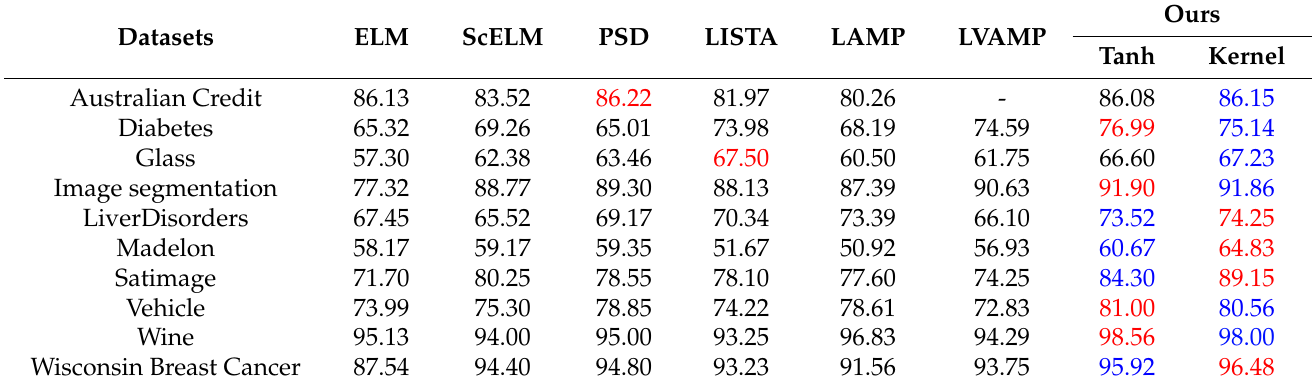
Table 7. The testing time of compared methods on UCI datasets. Datasets